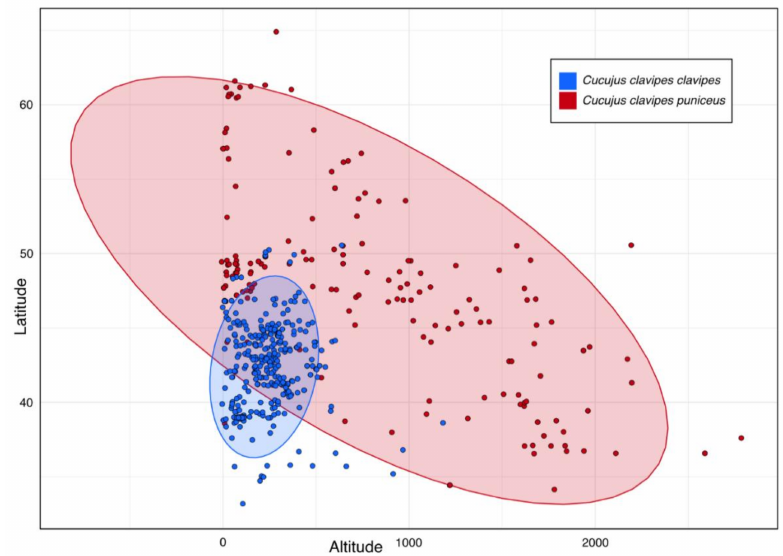
Figure 4. Distribution of Cucujus clavipes clavipes and C. c. puniceus along elevational and geographic gradients. Elipses include 95% of localities.